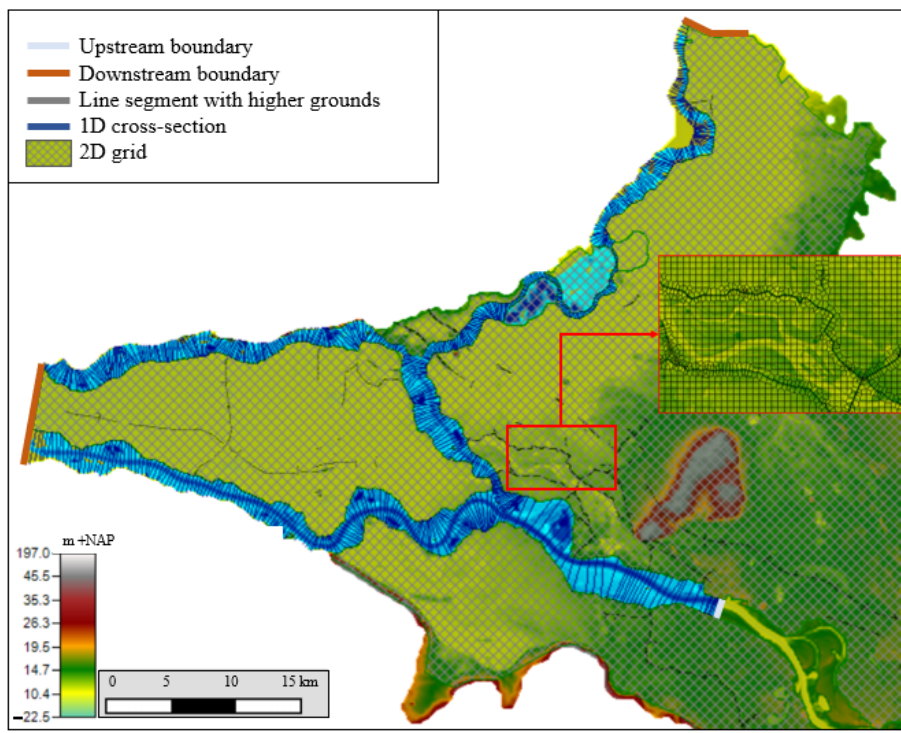
Figure 3. The 1D-2D coupled hydraulic model